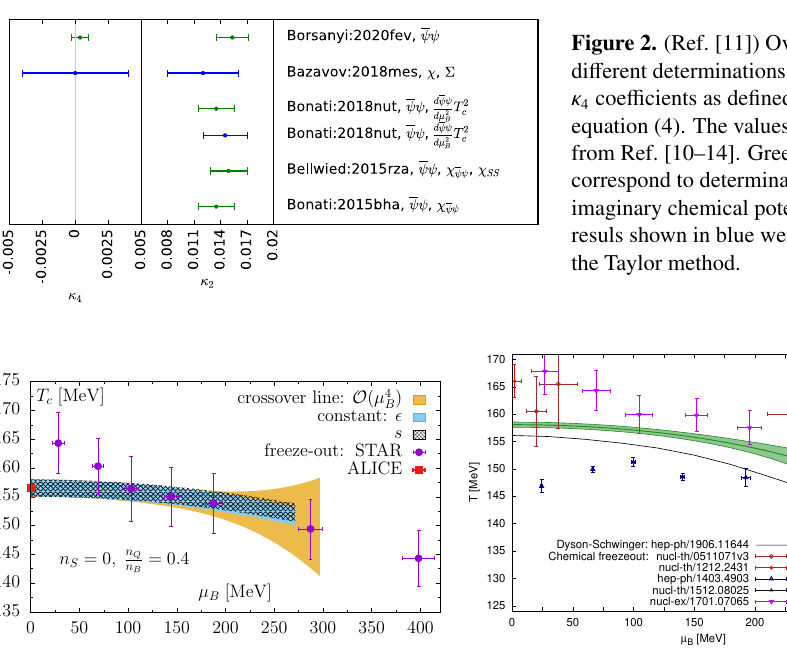
Figure 3. Left: (Ref. [10]) The extrapolation of the transition from the Taylor method compared with the freeze out temperatures from Ref. [20, 21], Right: (Ref. [11]) A comparison of the extrapo- lated transition temperature from simulations at imaginary chemical potential (green band) and Dyson- Schwinger-Equations (Ref. [22]). In addition the freeze-out temperatures obtained from heavy ion collisions in Ref. [15–19] are